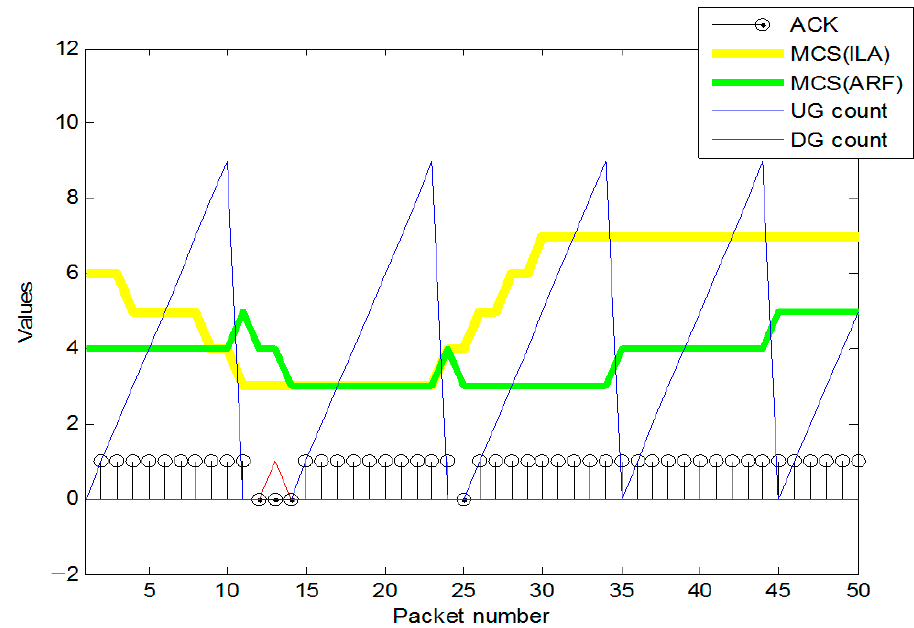
Figure 4. Automatic rate fallback (ARF) simulation results.